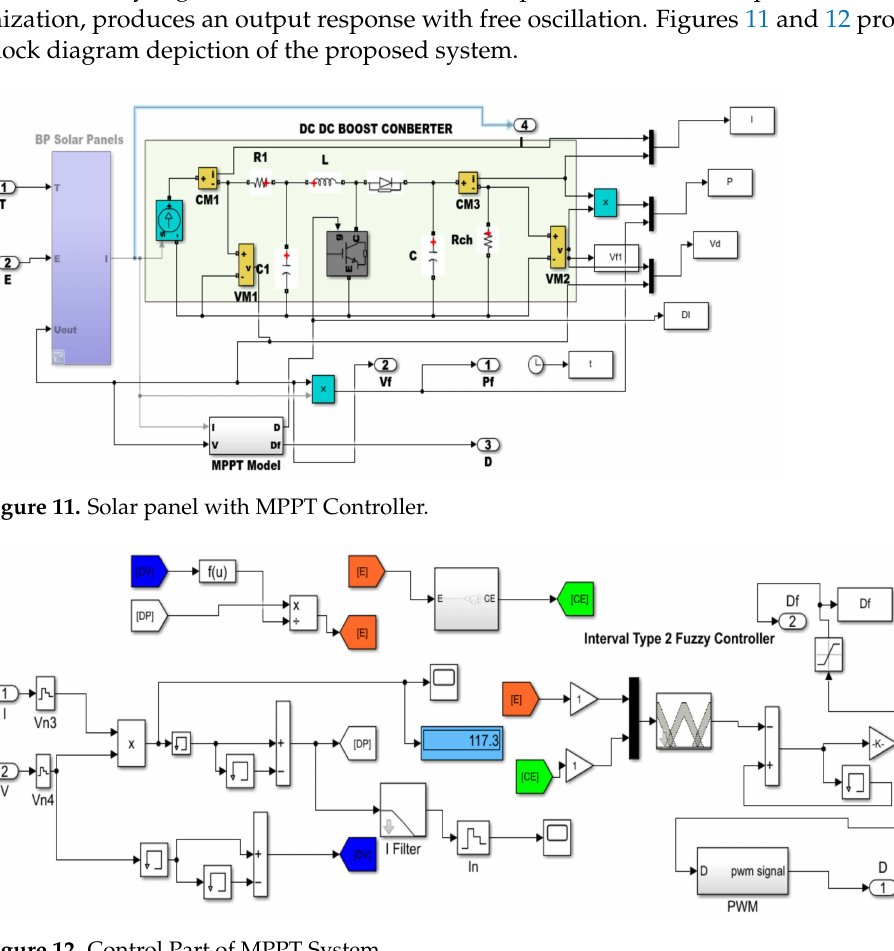
Figure 12. Control Part of MPPT System.